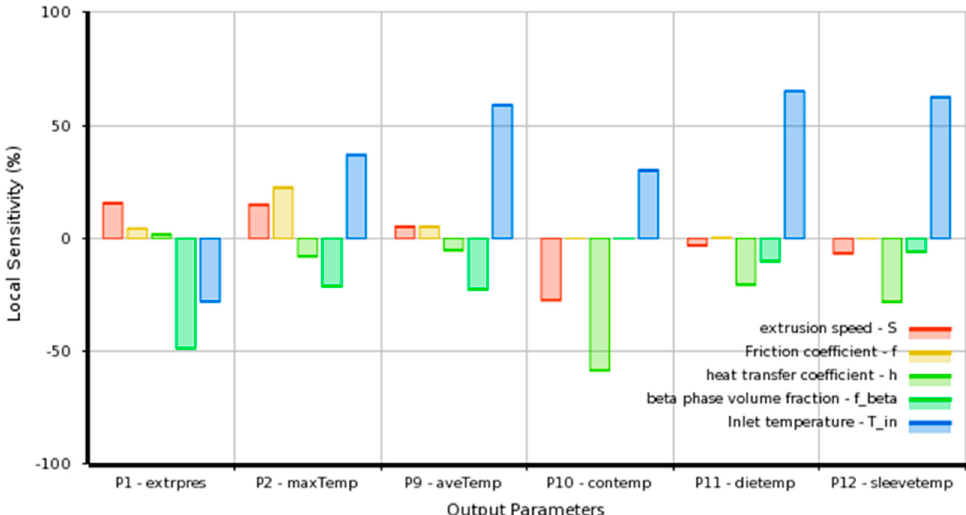
Figure 7. Sensitivity chart of the output parameters (designated by column—horizontal axis) with respect to the input parameters (designated by color bars). The analysis is performed in the neighborhood of a reference point with input parameter values: f = 5 × 10 8 Ns/m 3 ; S = 1.5 cm/s, f β = 0.5, T in = 715 °C, h = 1.7 W/(m 2 K).